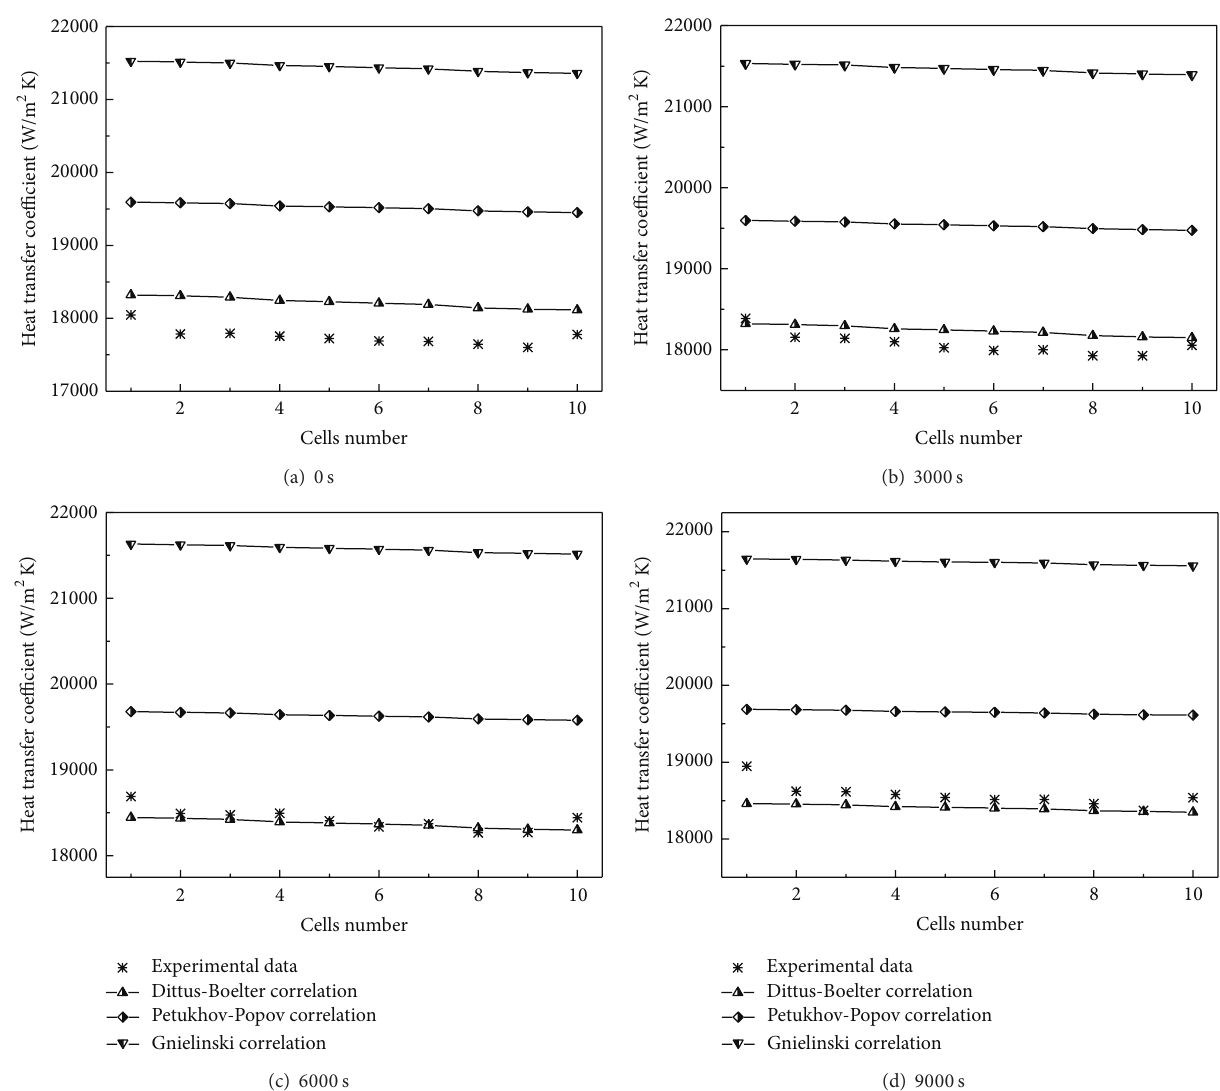
Figure 6: Comparison of tube inside heat transfer coefficients with single phase correlations in different cells along the heating tube at different